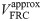
Relationship between constriction strength (% radius reduction) and MBW indices simulated using model M.(a)-(b) LCI, (c)-(d) Scond and (e)-(f) measured FRC volume VFRCapprox with constrictions applied to airways feeding 10% of the lung acinar volume. Three different depths were tested, corresponding to Strahler order 19-16 (proximal, black squares), 15-12 (central, red circles), and 11-8 (distal, blue diamonds), where all branches constricted were taken to be directly descended from the most proximal in all cases. (a), (c) and (e) show simulations where constrictions were all localised within the right-middle lobe, whereas (b), (d), and (f) show realisations where the positions of the constrictions were uniformly randomly distributed throughout the lung. Example animations of localised and random constrictions are shown in S1 and S2 Videos respectively.